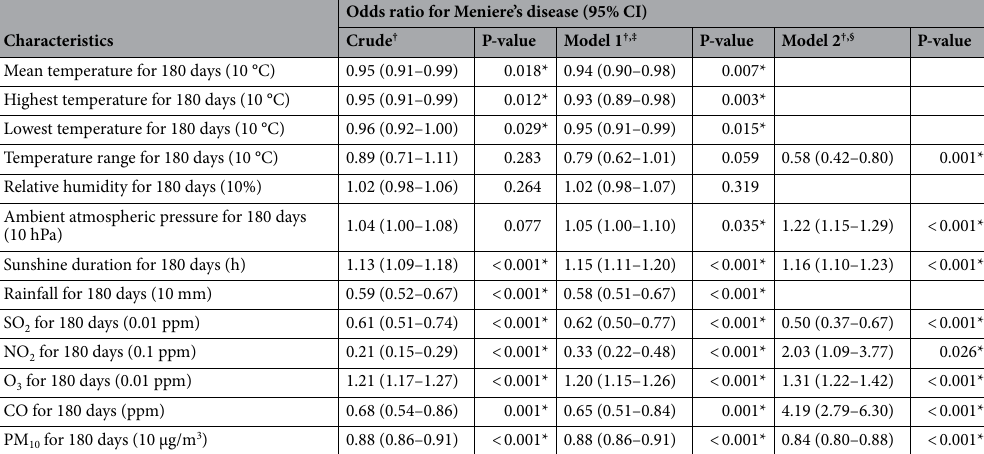
Table 3. Crude and adjusted odd ratios (95% confidence interval, CI) of the meteorological and pollution matter (mean of 180 days before index date) for Meniere’s disease. CCI Charlson comorbidity index, DBP diastolic blood pressure, SBP systolic blood pressure. *Conditional logistic regression model, Significance at P < 0.05. † Stratified model for age, sex, income, and region of residence. ‡ A model 1 was adjusted for total cholesterol, SBP, DBP, fasting blood glucose, obesity, smoking status, alcohol consumption, and CCI score. § A model 2 was adjusted for full insertion using forward selection method. The model was finally adjusted for temperature range, ambient atmospheric pressure, sunshine duration, SO 2 , NO 2 , O 3 , CO, PM 10 , obesity, smoking status, CCI score, fasting blood glucose, SBP, benign paroxysmal vertigo, vestibular neuronitis, and other peripheral